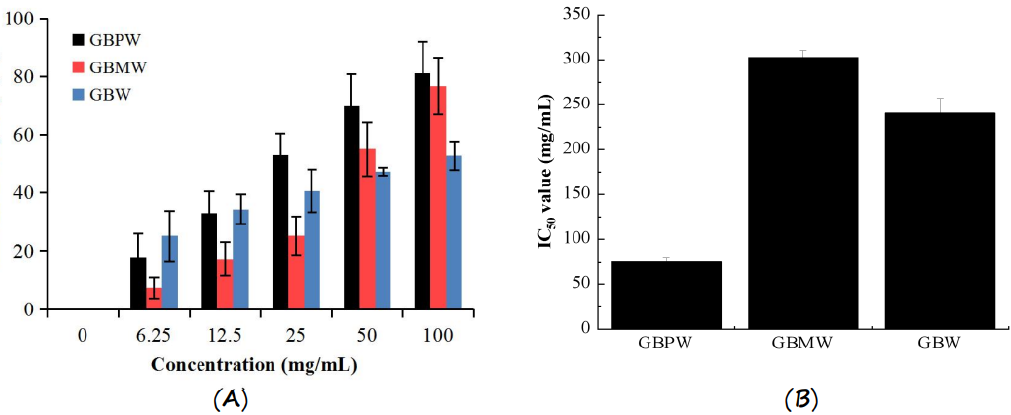
Figure 6. ( A ) Antioxidant capacities and ( B ) IC 50 values of green banana wine samples on cell viability of 3T3-L1 preadipocytes.